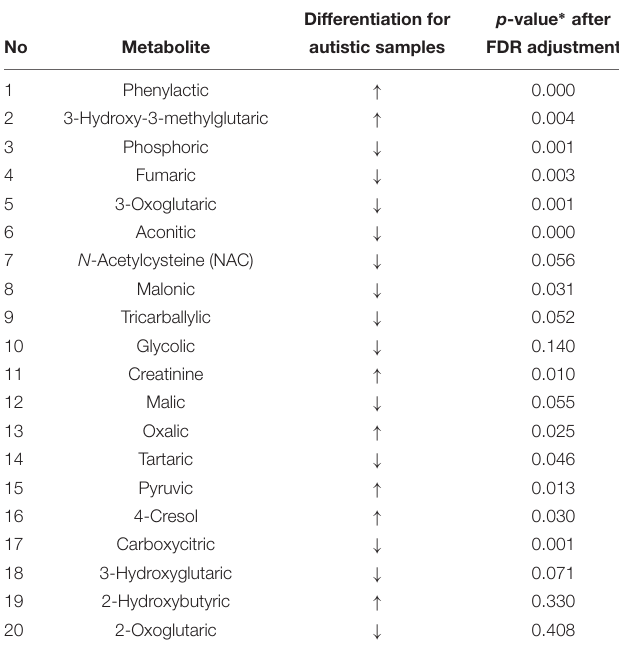
TABLE 2 | Potential marker metabolites found in GC/MS of urine